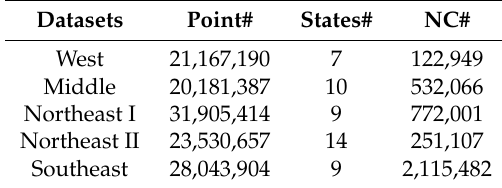
Table 2. Statistics of five sub-regions in the US (# represents